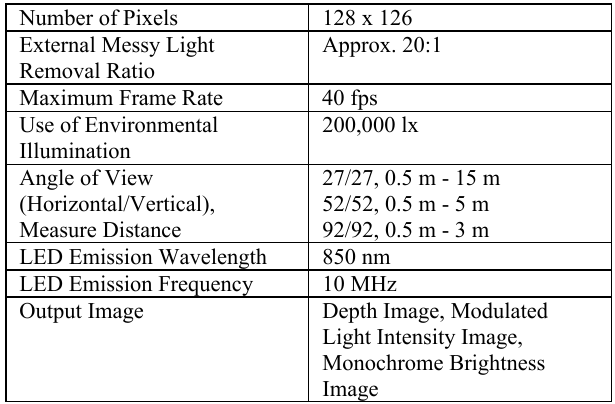
Table 1 . Distance camera specifications.